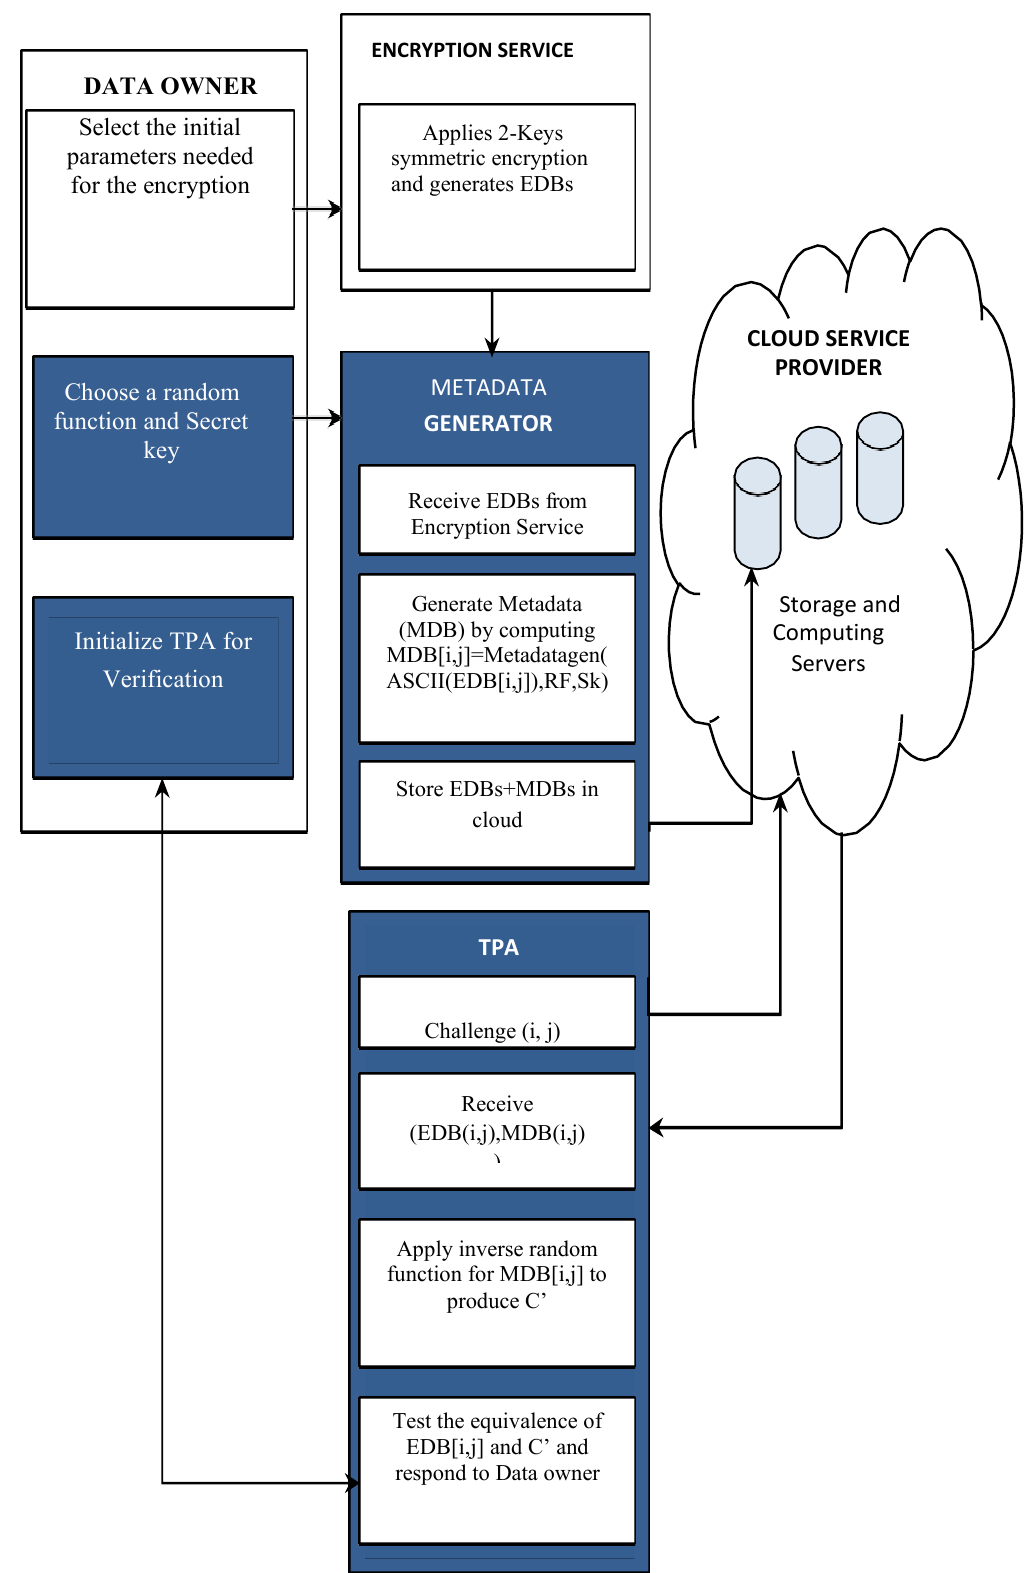
Figure 1.2. Architecture for data integrity in cloud